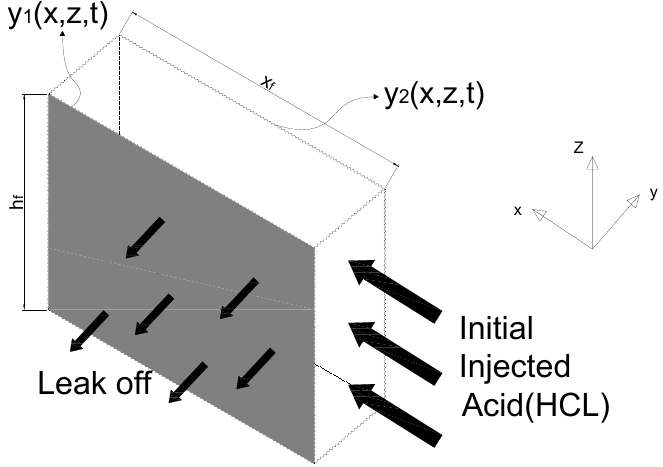
Figure 2. The domain of the acid model.